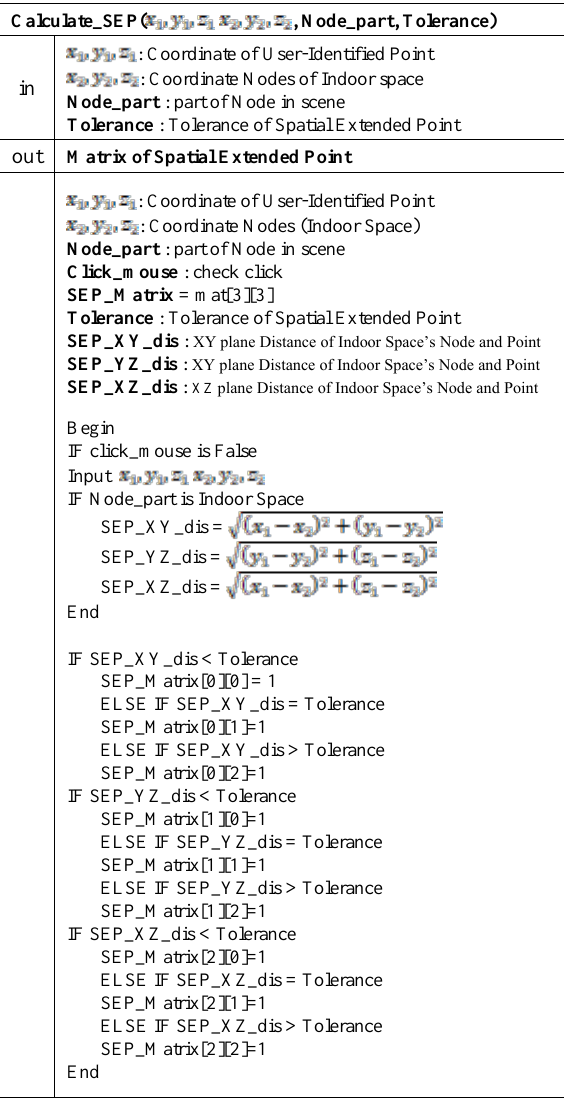
Figure 9. Pseudocode for the SEP Matrix